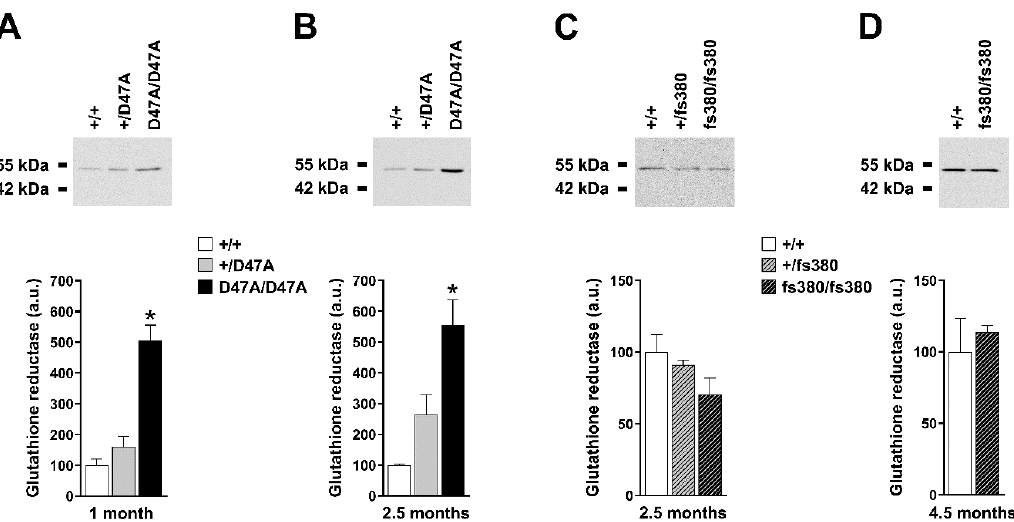
Figure 3. Levels of glutathione reductase in Cx50D47A and Cx46fs380 lenses. ( A , B ) Top panels. Immunoblots of glutathione reductase in whole lens homogenates from 1- (A) and 2.5- (B) month-old mice that were wild type for Cx50 (+/+) or heterozygous (+/D47A) or homozygous (D47A/D47A) for Cx50D47A. The migration positions of the molecular mass markers are indicated on the left. Bottom panels. Graphs show the densitometric quantification of the glutathione reductase immunoreactive band obtained in three independent experiments. Data are presented as the mean (bar) + standard error of the mean. ( C , D ) Top panels. Immunoblots of glutathione reductase in whole lens homogenates from 2.5- (C) and 4.5- (D) month-old mice that were wild type for Cx46 (+/+) or heterozygous (+/fs380) or homozygous (fs380/fs380) for Cx46fs380. The migration positions of the molecular mass markers are indicated on the left. Bottom panels. Graphs show the densitometric quantification of the glutathione reductase immunoreactive band obtained in three independent experiments. Data are presented as the mean (bar) + standard error of the mean. Asterisk denote a significant difference compared with wild-type lenses ( p < 0.05). Note that at 2.5 months of age, levels of glutathione reductase in heterozygous Cx50D47A lenses ( p = 0.12), heterozygous Cx46fs380 lenses ( p = 0.54) and homozygous Cx46fs380 lenses ( p = 0.15) were not different from those in wild-type lenses.